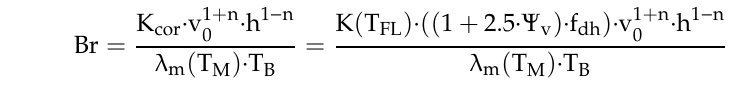
Figure 10. Viscosity above the shear rate for PP ( a ) and LDPE ( b ) and various solid contents.